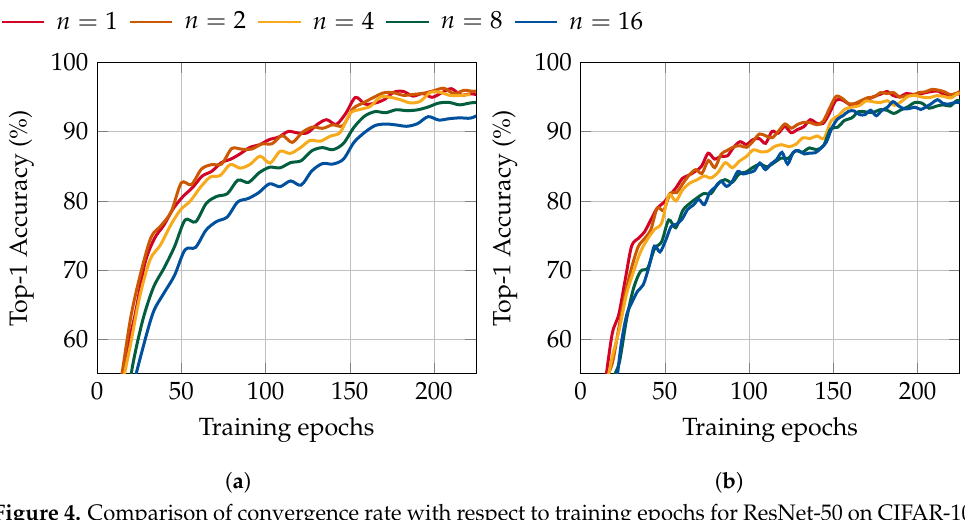
Figure 4. Comparison of convergence rate with respect to training epochs for ResNet-50 on CIFAR-10;